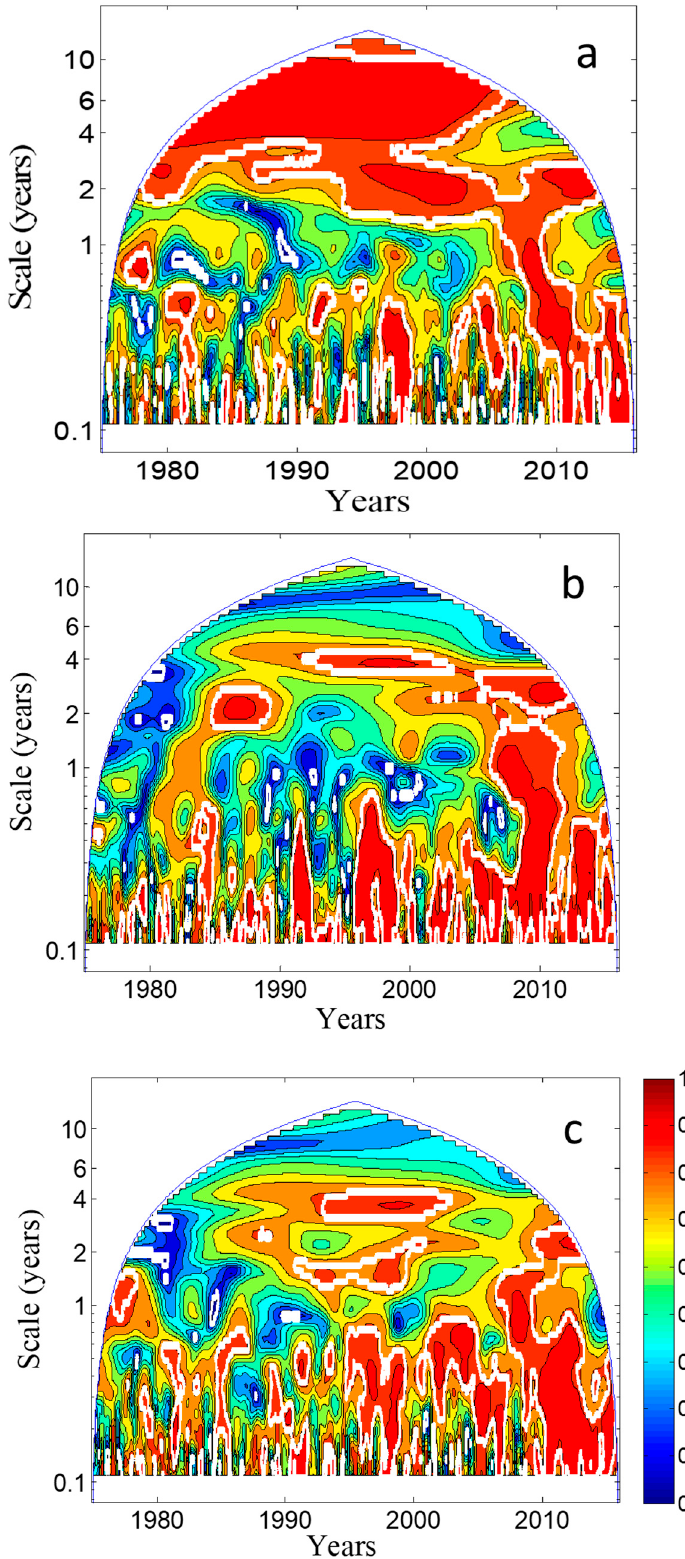
Figure 6. Wavelet coherence spectra. Axes as in WPS spectra. Only coherences inside the cone of influence (COI) are represented by a color scale. The white line limits 95% significant areas. ( a ) Discharge-sodium; ( b ) discharge-sulfate; ( c ) sulfate-sodium.